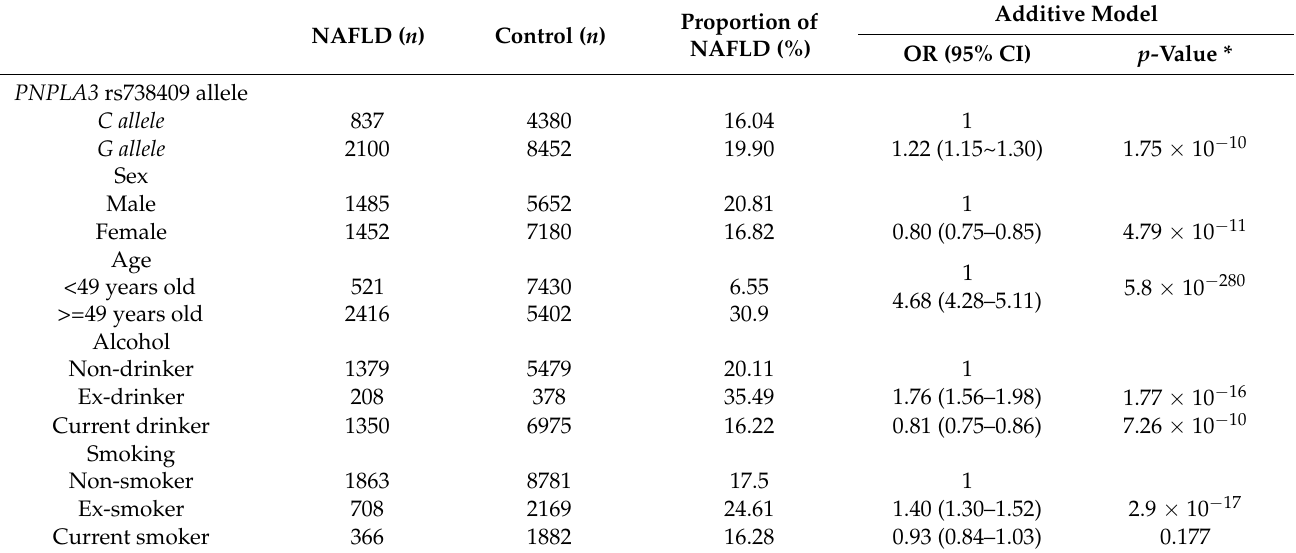
Table 2. Genetic risk of PNPLA3 rs738409 G allele on non-alcoholic fatty liver disease (NAFLD) occurrence in multivariable logistic regression